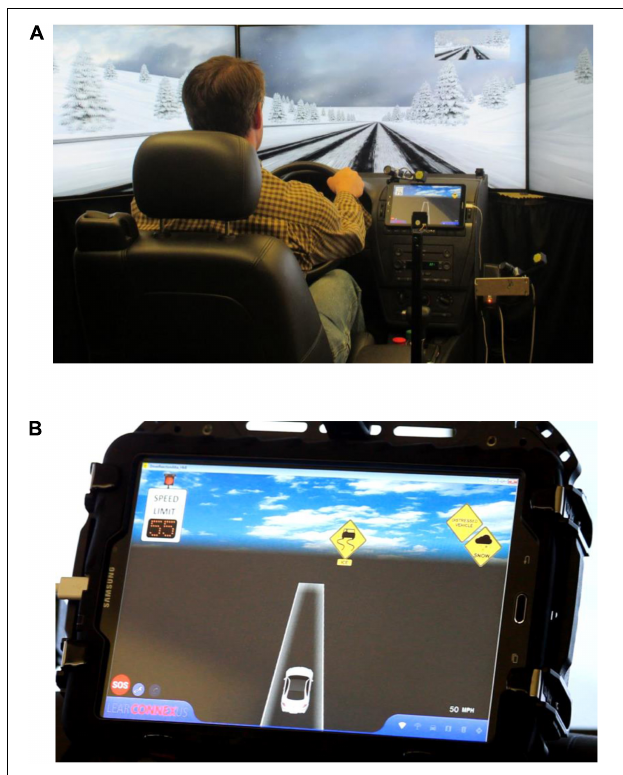
FIGURE 3 | Illustration of driving simulator study at WyoSafeSim lab: (A) A simulation scenario; (B) CV